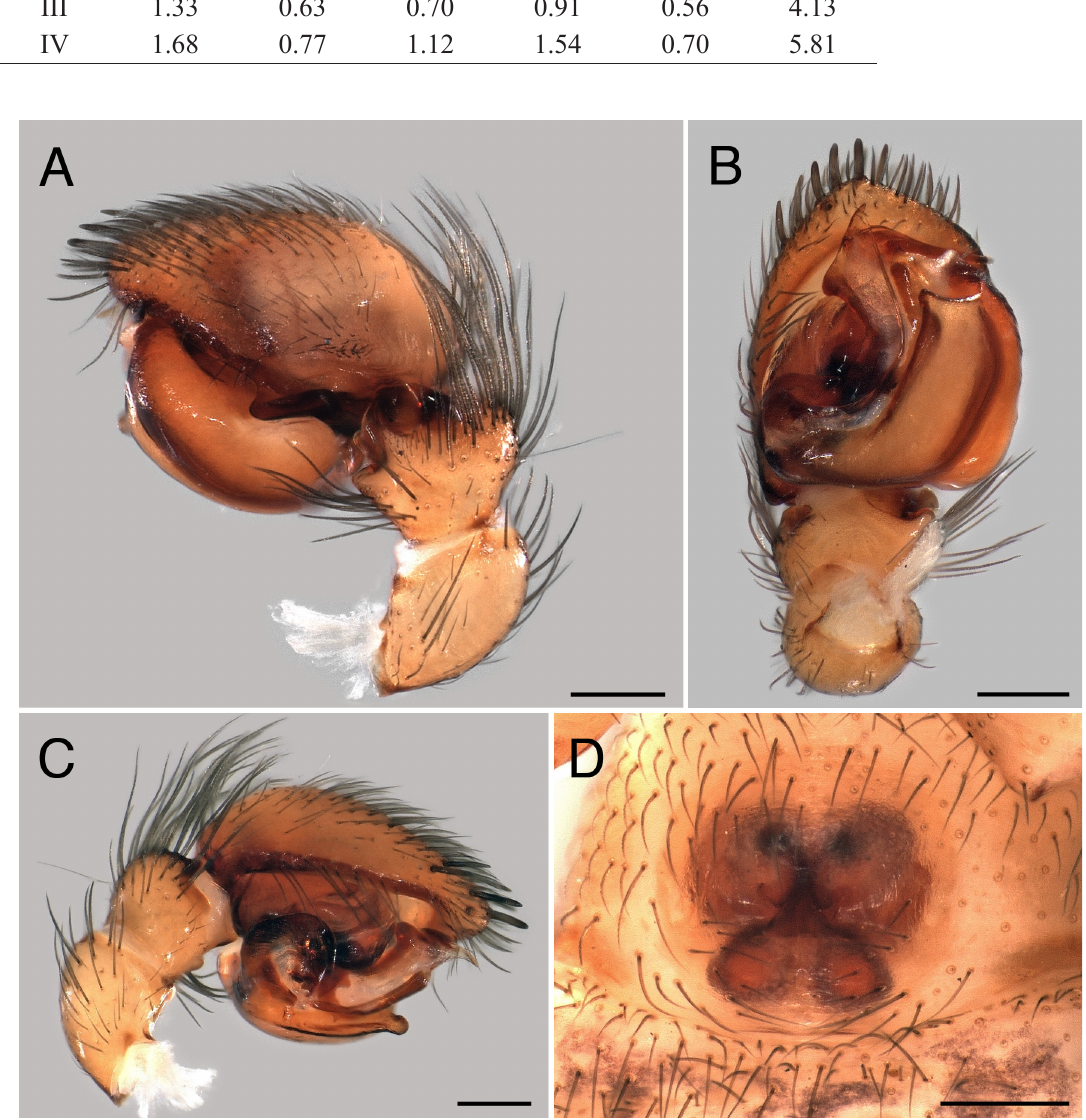
Fig. 4. Ballomma erasmus gen. et sp. nov. A–C . Holotype, ♂. D . Paratype, ♀. A . Male palp, retrolateral, slightly posterior and dorsal, view. B . As preceding, ventral view. C . As preceding, prolateral view. D . epigyne, ventral view. Scale bars: 0.2